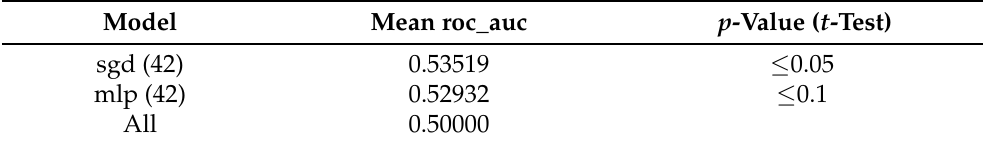
Table A9. Models with significantly better mean ROC (auc).